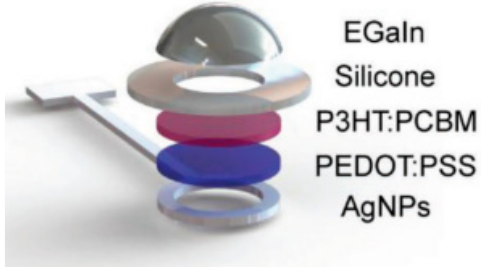
Figure 4. Structure of photodetector. Reproduced from [56], 2018, Wiley.